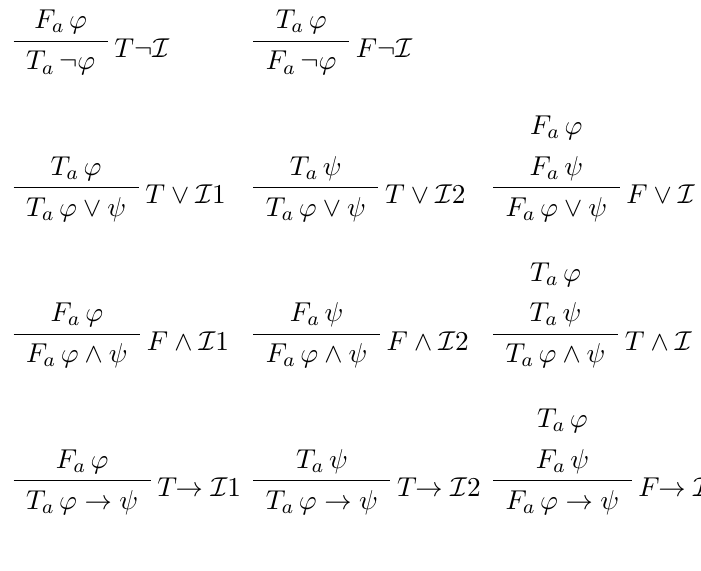
Table 2. Sufficient conditions (introduction rules) for the standard Boolean